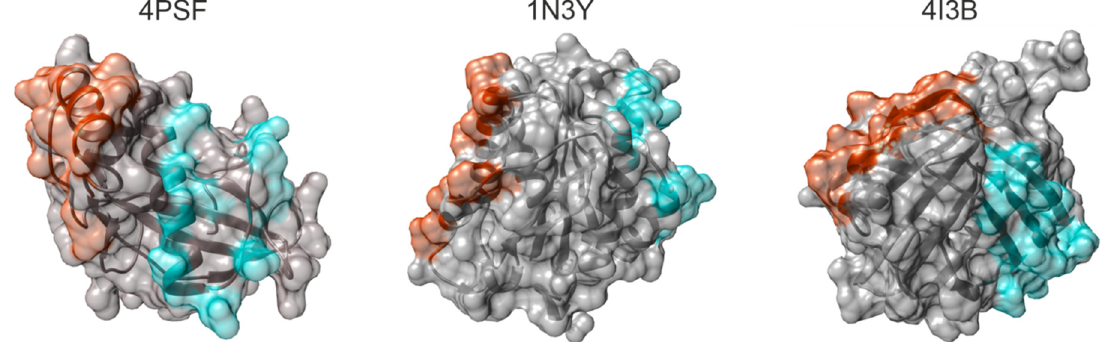
Figure 1. Surface patches of mutable residues identified in the structures of Protein Data Bank (PDB) IDs 4PSF [42], 1N3Y [52], and 4I3B [51]. The proteins are shown as ribbons in semitransparent surface representation. Residues constituting PatchN and PatchC in each protein are colored red and cyan, respectively.